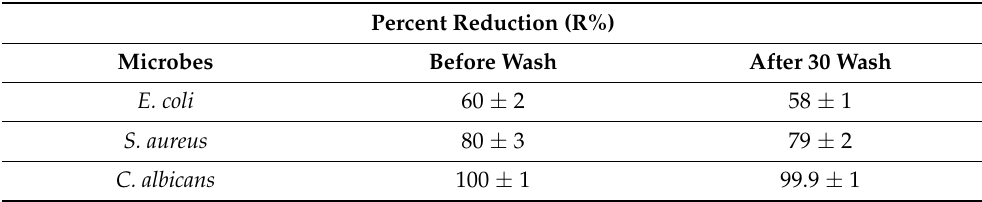
Table 3. Antibiofilm activity of Se-coated-30 after 30 wash cycle. Data are represented as means with standard deviations ( n = 3). Statistical analysis were performed by the Student’s t